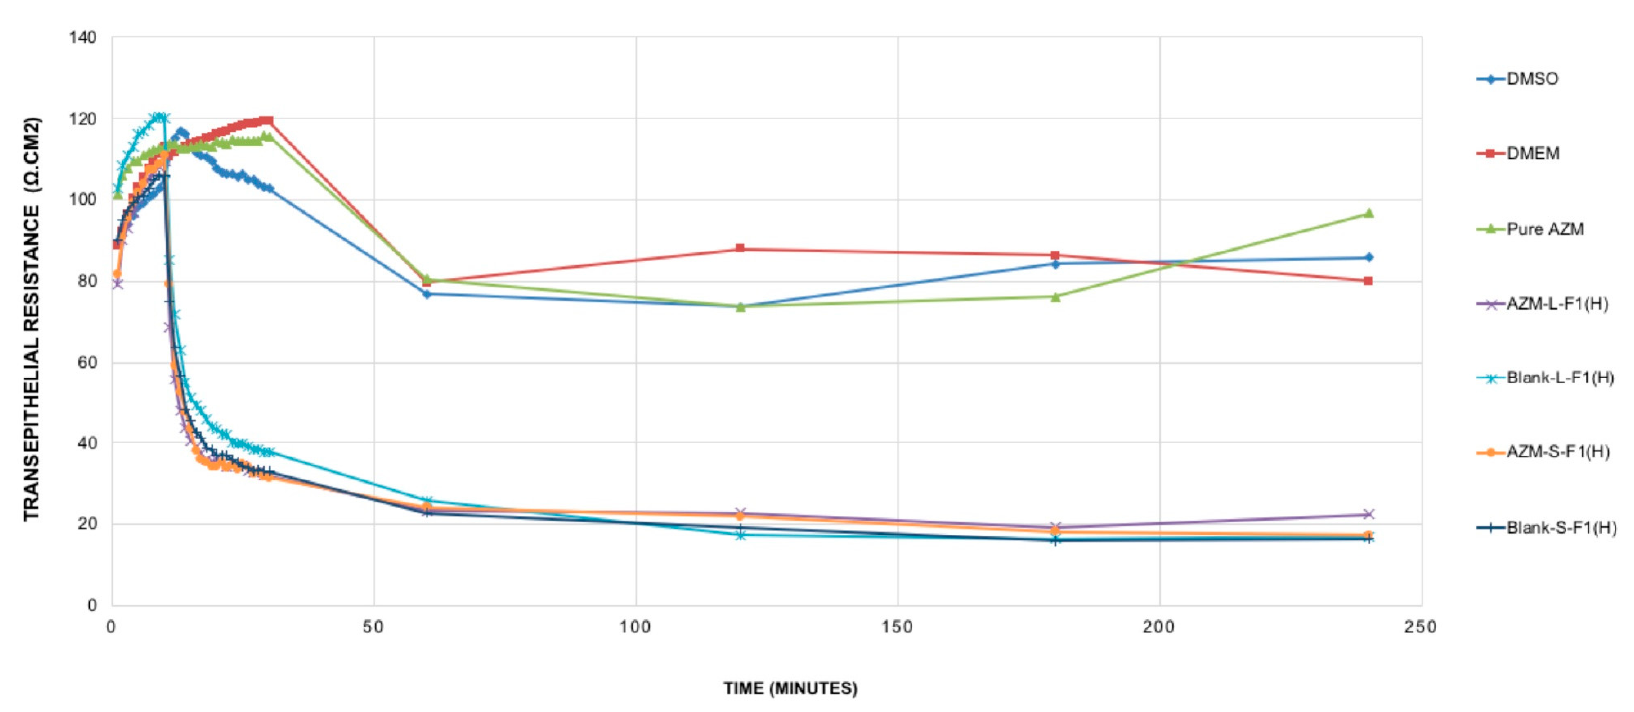
Figure 6. TEER resistance of the studied samples. Mean ± SEM, n = 3. DMSO: dimethyl sulfoxide, DMEM: Dulbecco’s modified eagle’s medium, AZM-L-F1 (H) : Azithromycin-loaded liquid SEDDs, Blank L-F1 (H) : Blank liquid SEDDS, Pure AZM: Pure Azithromycin, AZM-S-F1 (H) : Azithromycin-loaded solid SEDDs, Blank S-F1 (H) : Blank solid SEDDS.